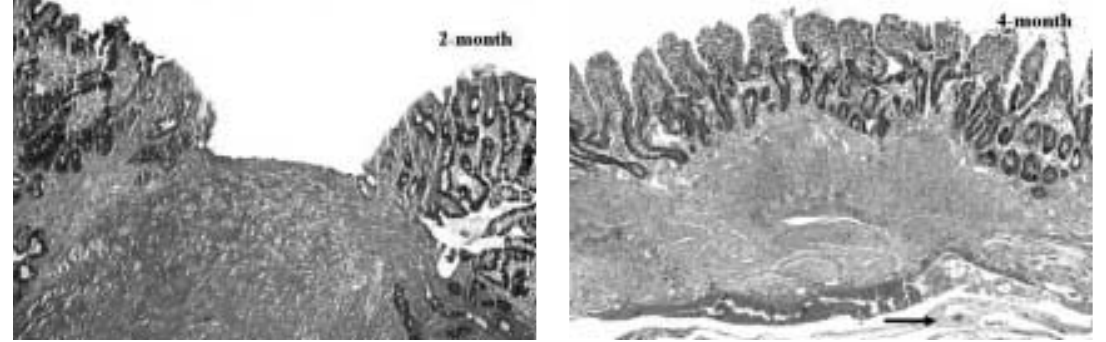
Two month specimen. Photomicrograph showing single layer of columnar epithelial cells in the central area of the flap. Irregular and poorly developed villi were observed at the lateral margins (HE × 10).